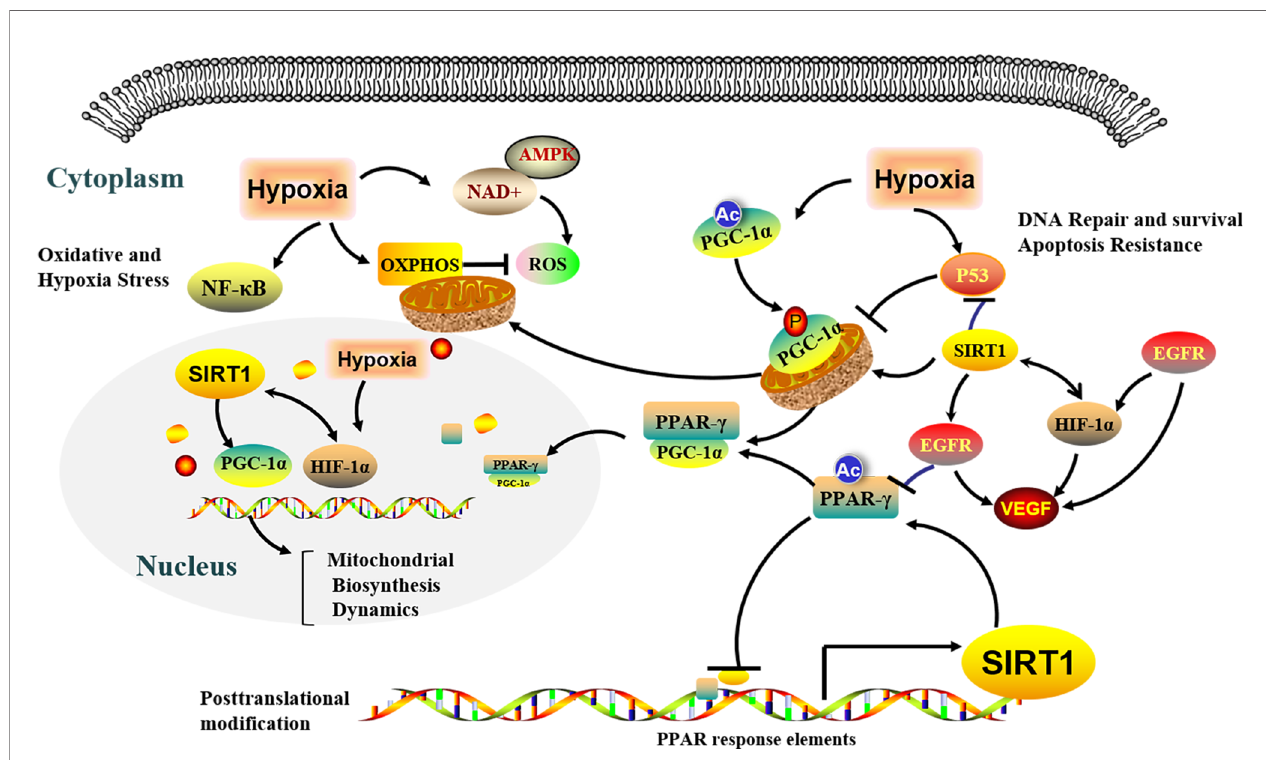
FIGURE 3 | Regulation of metabolic microenvironment via SIRT1/PGC-1 a /PPAR- g signaling pathways under hypoxia conditions. Several potentially effective molecular mechanisms of regulation of metabolic microenvironment have been shown in non-small cell lung cancer under hypoxia conditions, by which SIRT1 mediated deacetylation modi fi ed of downstream transcription factors and modulated metabolic adaptation. SIRT1, Silent information regulator 1; PGC-1 a , Peroxisome proliferator — activated receptor- g coactivator-1 a ; PPAR- g , Peroxisome proliferator activated receptor- g ; EGFR, Epidermal growth factor receptor; VEGF, Vascular endothelial growth factor; HIF-1 a , Hypoxia inducible factor-1alpha; OXPHOS, Oxidative phosphorylation; ROS, Reactive oxygen species; NAD+, Nicotinamide adenine dinucleotide; AMPK, Adenosine monophosphate activated protein